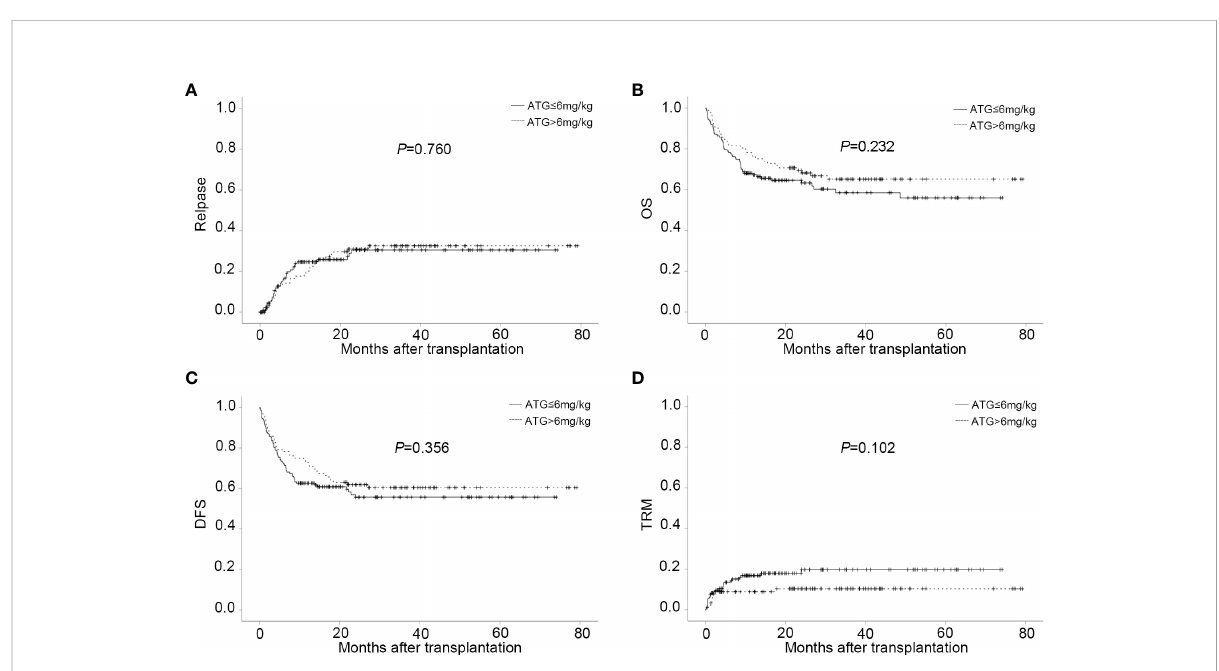
FIGURE 3 CIs of post-transplant outcome in different ATG doses groups. (A) CI of relapse in different ATG doses groups. (B) CI of OS in different ATG doses groups. (C) CI of DFS in different ATG doses groups. (D) CI of TRM in different ATG doses